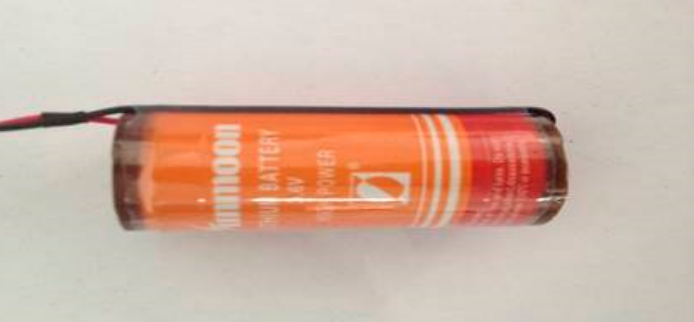
Figure 6. A 7000mAh/3.6 V lithium battery.